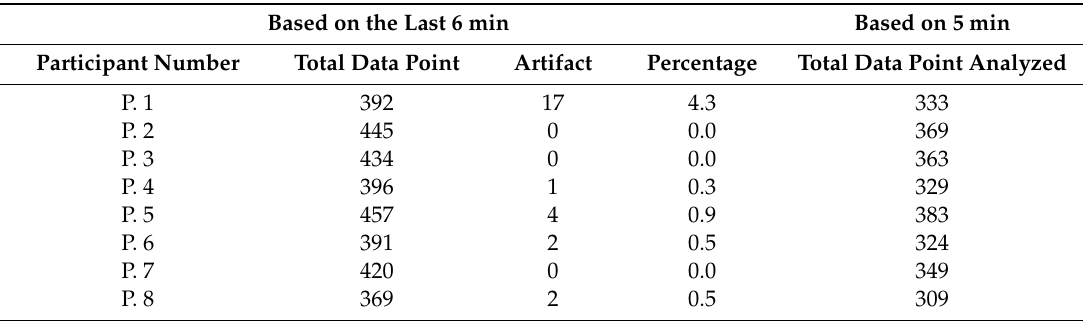
Table 3. Identification and deletion of the artefact based on the last 6 recorded minutes and the number of the final data points used in HRV